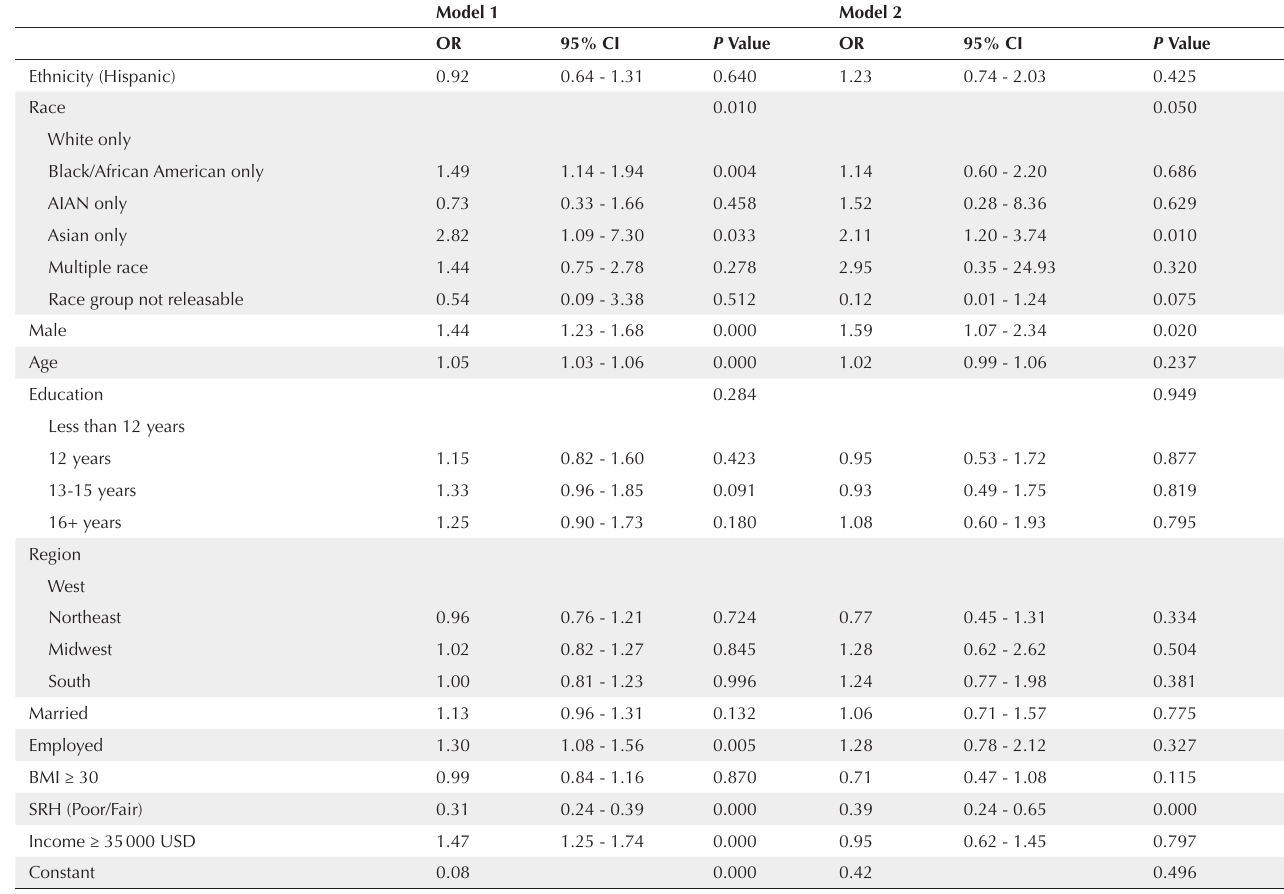
Table 3. Logistic Regressions in Non-immigrants and Immigrants (n = 14 149)